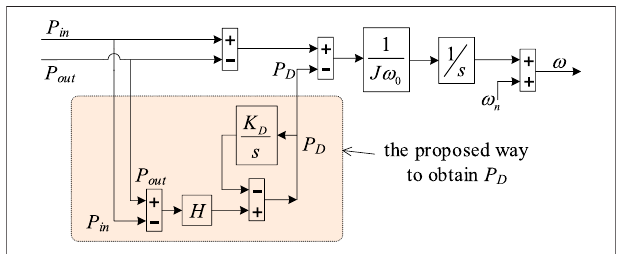
FIGURE 6 | Block diagram of the swing equation of the proposed method.